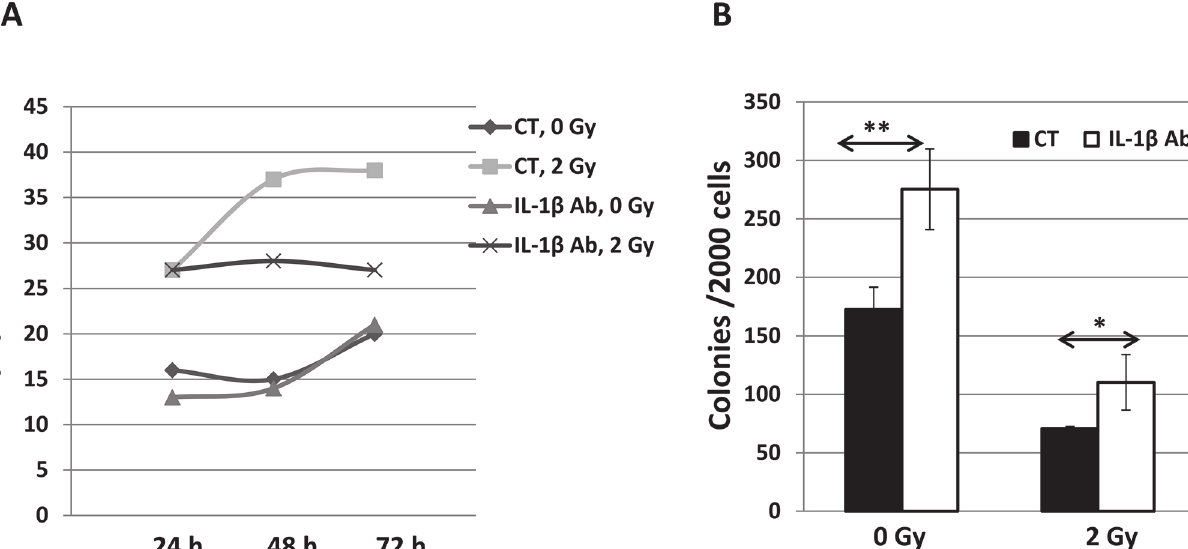
Fig 6. An anti-IL-1 β antibody protected CD34+ cells from radiation-induced apoptosis. The anti-IL-1 β antibody (0.2 μ g/mL) or the same amount of nonspecific IgG as a control (CT) were added into CD34+ cell culture 1 h before sham- or 2 Gy radiation. (A) Cells were analyzed by flow cytometry with apoptotic and cell death marker Annexin-V and 7AAD staining at 24, 48, and 72 h after irradiation. Frequency of apoptosis (Annexin-V and 7AAD positive) cells is shown. (B) Clonogenic assay on survival of human hematopoietic progenitor cells was performed 1 day after irradiation. Colonies were counted at 14 days of culture. Colony generation was inhibited by radiation, and this inhibition was ameliorated by neutralization of IL-1 β bioactivity using anti-IL-1 β antibody. * p < 0.05, ** p < 0.01; mean ± SD. Anti-IL-1 β antibody vs. IgG control.